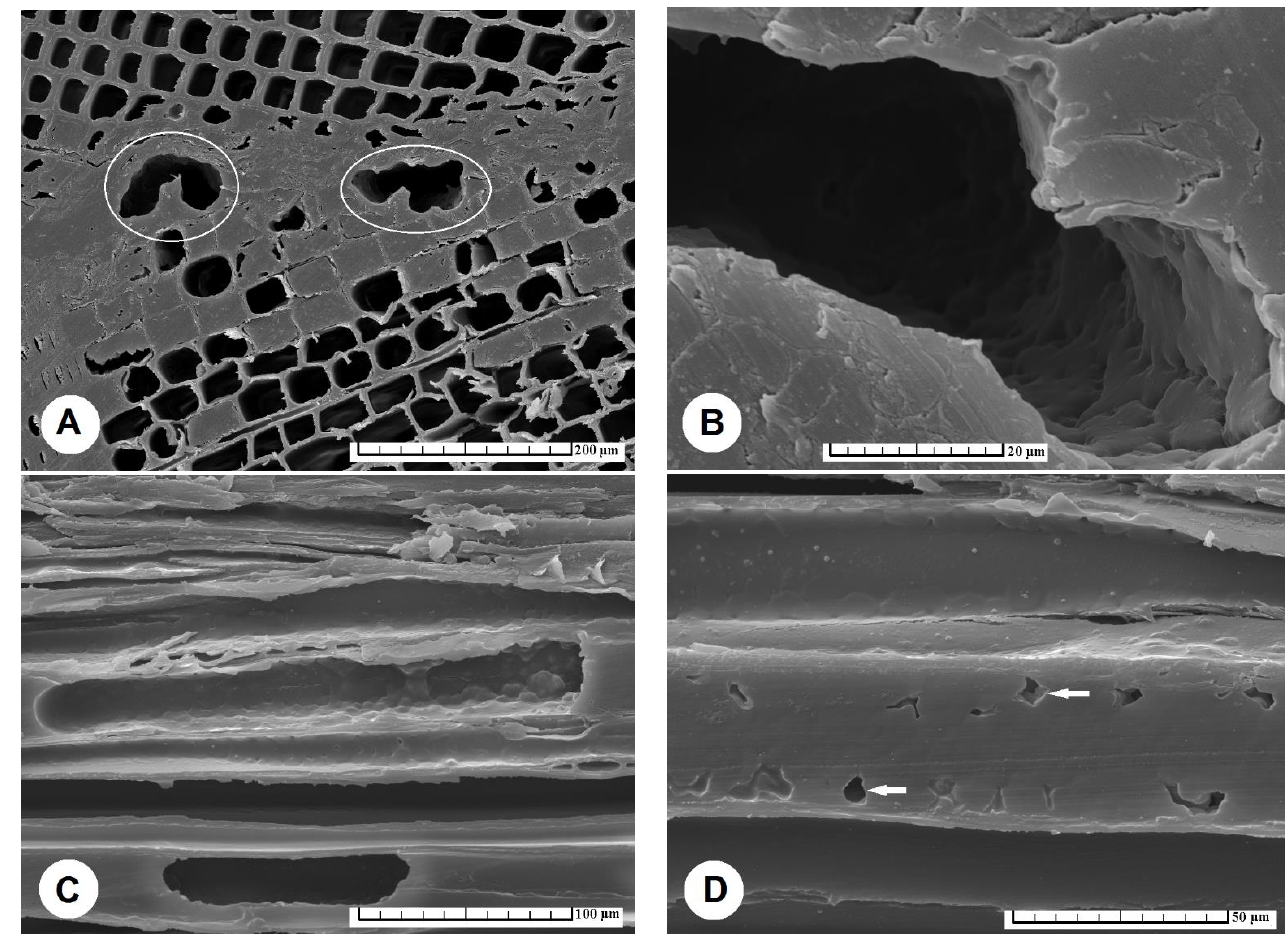
Figure 5. In the joints of TM spruce wood with PUR glue are seen typical micro-bubbles, including ( A ) irregular bubbles (100 –150 μm, white ellipses) formed in the glued joint of the combined testing set VI 100 °C/ 220 °C, ( B ) a detail of the structure of the inner surface of bubbles in the cross-section cut of the glued joint, ( C ) a detail of the longitudinal shape of bubbles (100 –200 μm) in the lumens of ET of TM wood (220 °C) on the longitudinal cut of the glued joint, ( D ) a detail of forming small micro- ruptures with the dimension of ~5 μm (white arrows) in the PUR glue coat on the S3 layer of cell wall. Scale bars = 20 to 200 μm .